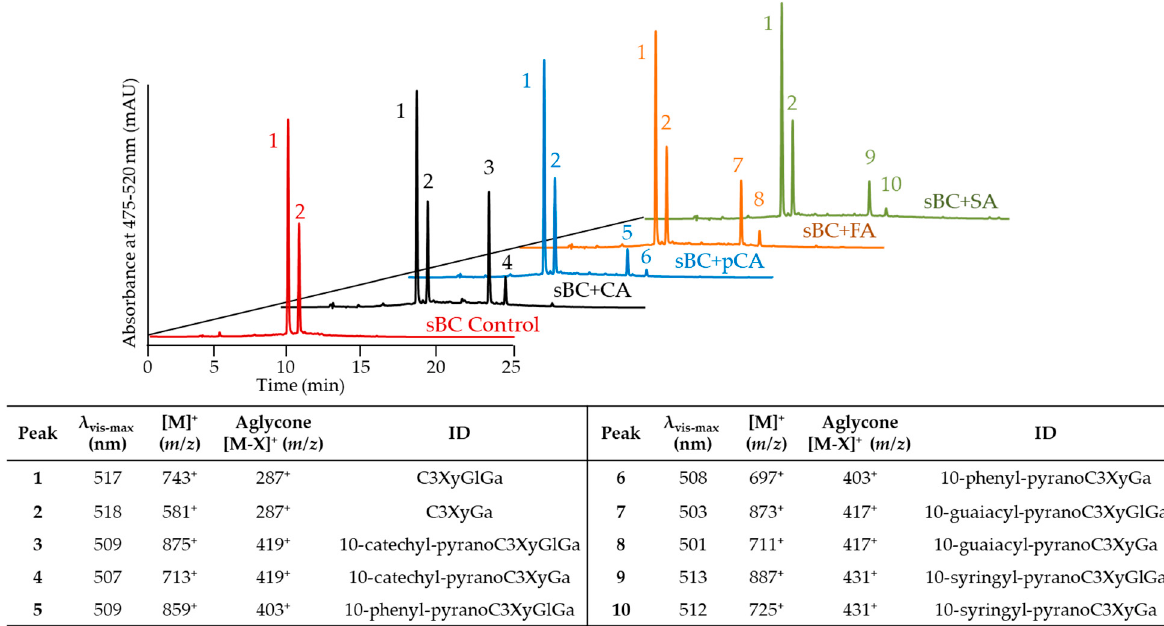
Figure 3. Comparing the pyranoanthocyanin formation after 72 h of anthocyanin (saponified black carrot, sBC) incubation with caffeic acid (CA), p -coumaric acid (pCA), ferulic acid (FA), and sinapic acid (SA). Chromatograms show the max plot in the 475–520 nm range. Table shows the wavelength of maximum absorption in the visible range ( λ vis-max ), mass-per-charge ratio ( m / z ) of the main ion and its aglycone, and tentative identity (ID). C3XyGlGa: cyanidin-3- O -xylosyl-glucosyl- galactoside, C3XyGa: cyanidin-3- O -xylosyl-galactoside. Yields calculated using Equation (1) and displayed in Figure 4 showed that after 24 h of incubation, PACN yield with CA (12.5 ± 0.2%) was significantly greater than with FA